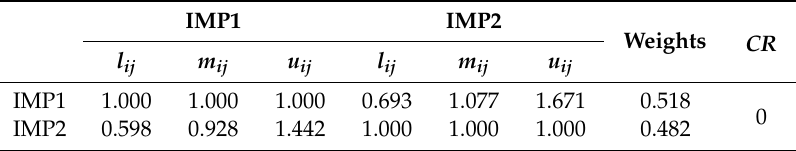
Table 6. Combined judgement matrix using geometric means for the subcriteria of the criterion Impact of operation.